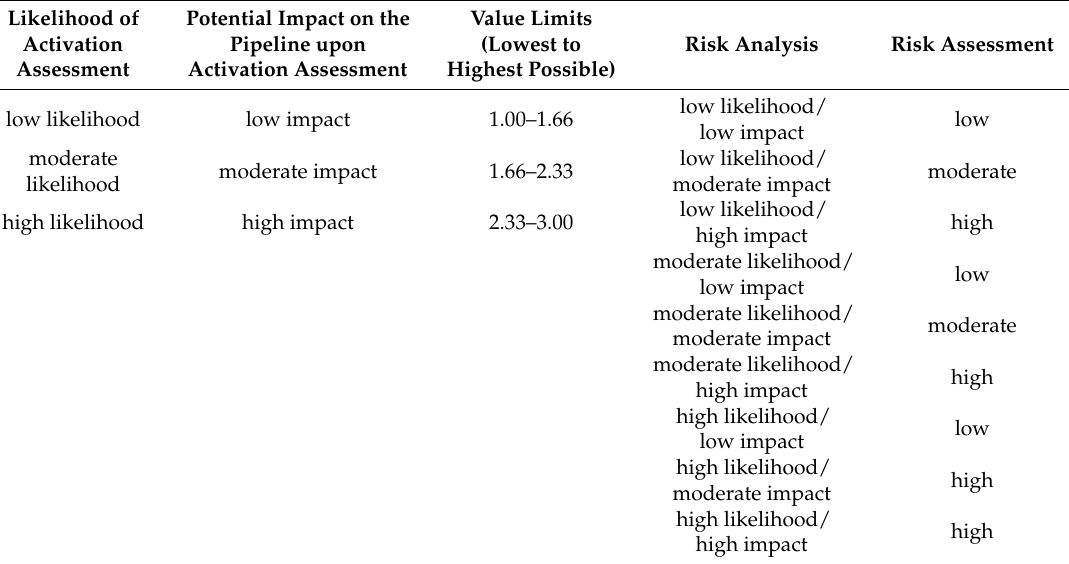
Table 4. Risk assessment estimation scheme adopted in the present